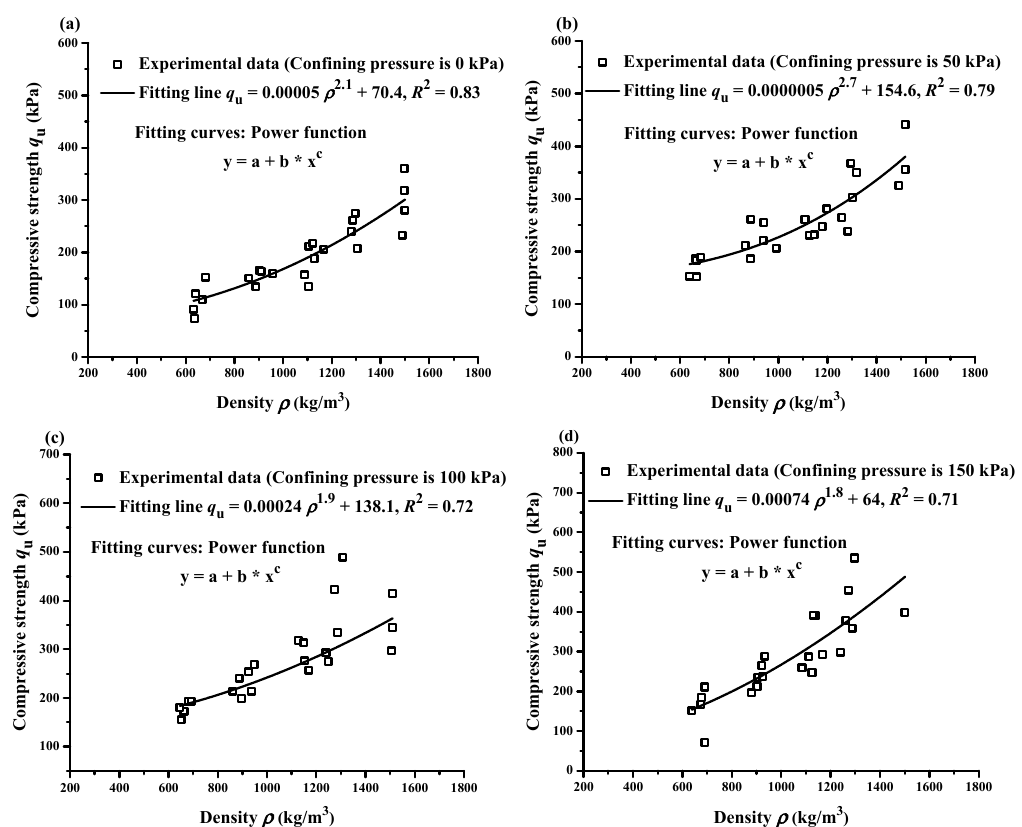
Figure 12. Relationship between compressive strength and density under different confining pressures: ( a ) 0 kPa; ( b ) 50 kPa; ( c ) 100 kPa and ( d ) 150 kPa.